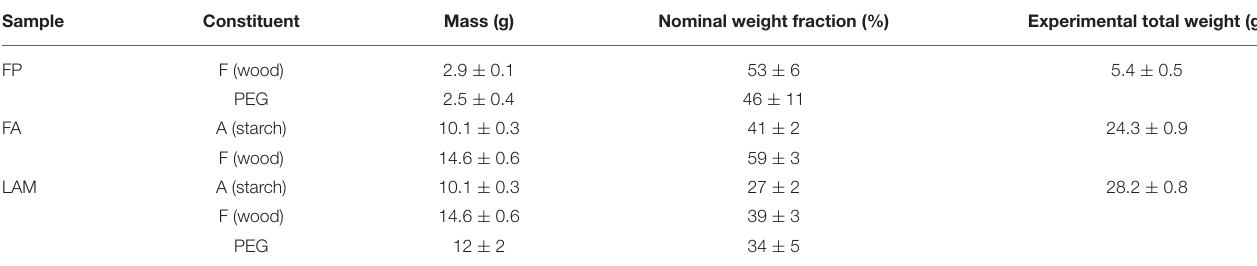
TABLE 2 | Mass and weight fraction of the constituents of the sample FP and the two laminates (FA and LAM).